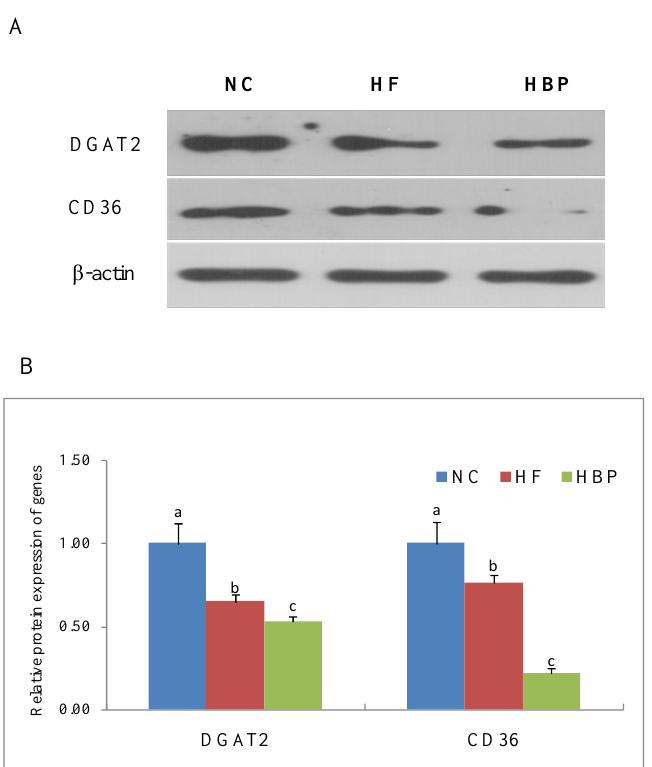
Figure 6. Effects of HBP on the protein expression of DGAT2 and CD36 in the intestinal mucosa of high-fat-diet fed mice: ( A ) Representative bands of immunoblot; ( B ) relative protein levels of DGAT2 and CD36. Values not sharing a letter in common are significantly different, p <